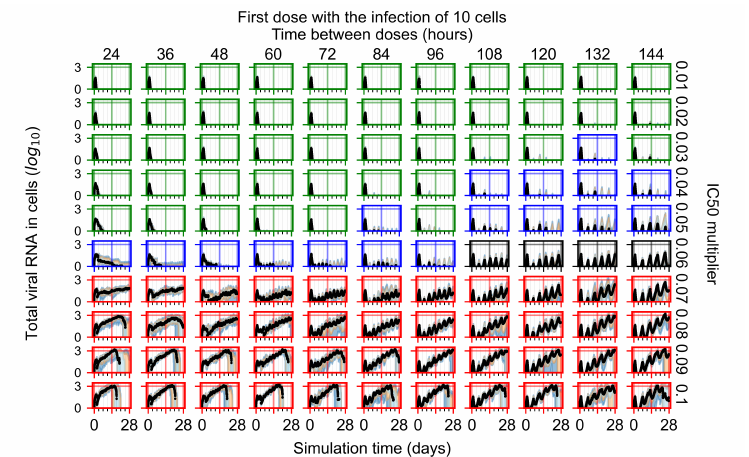
Figure A11. Diffusive cytokine amount, Y axis in log scale, and exponent values as tick marks.